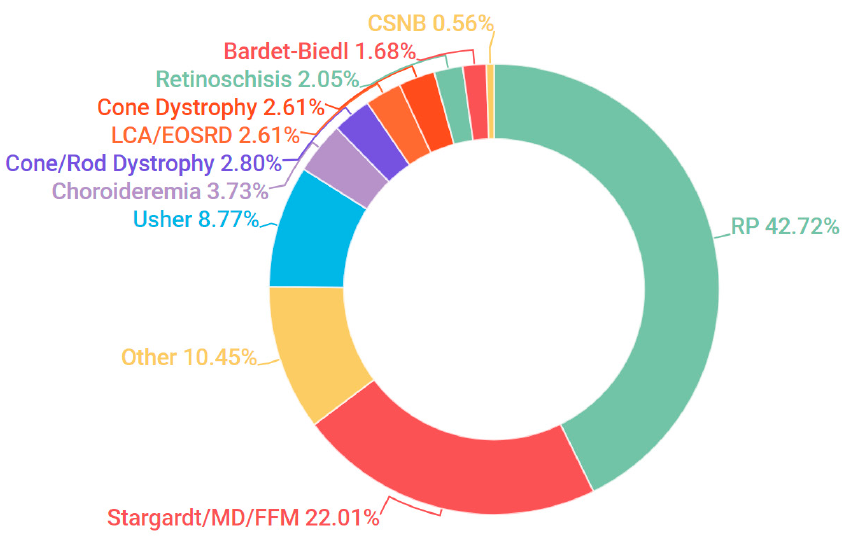
Figure 1. Clinical presentation of all inherited retinal degeneration(IRD) pedigrees included in the